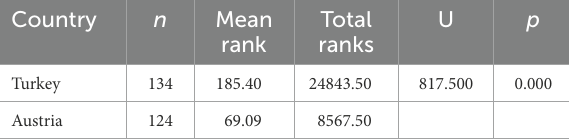
TABLE 5 U-Test results of similarity indexes of postgraduate theses based grouped by